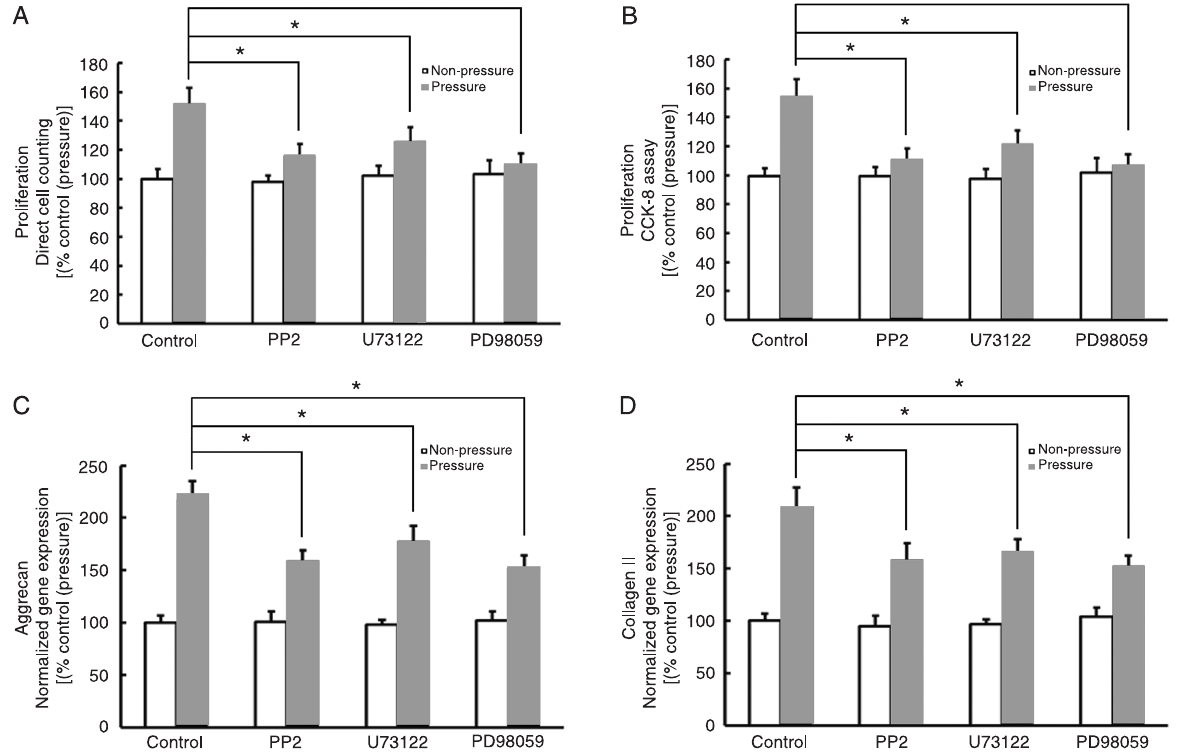
Figure 3. PP2, U73122 and PD98059 inhibit periodic mechanical stress-induced cell proliferation and matrix synthesis. After pretreat - ment with DMSO or ERK1/2 inhibitor (PD98059), PLCγ1 inhibitor (U73122) and Src inhibitor (PP2), rat chondrocytes were cultured for 3 days under static conditions or conditions of periodic mechanical stress 8 h per day prior to proliferation studies. Cell proliferation was analyzed by direct cell counting ( A ) and CCK-8 assay ( B ). Chondrocytes were cultured in vitro for 8 h under static conditions or periodic mechanical stress prior to matrix synthesis studies. Aggrecan ( C ) and type II collagen ( D ) gene expression were measured to indicate the level of matrix synthesis, which was measured by quantitative real-time PCR. Chondrocyte proliferation and matrix synthesis in the inhibitor pretreatment groups was significantly decreased relative to control in chondrocytes in response to periodic mechanical stress (N = 5, *P < 0.05, Student unpaired t